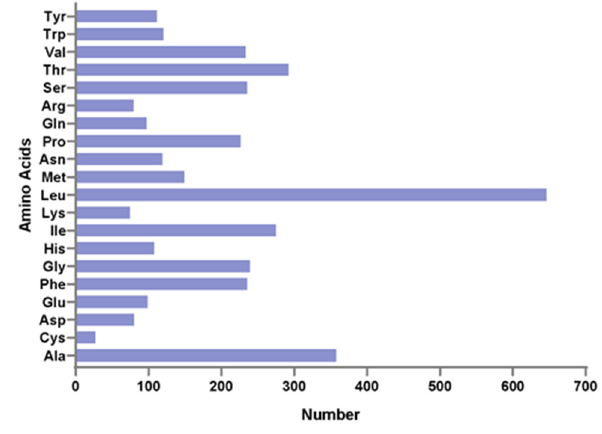
Figure 2. Amino acid distribution of the P. dentex mitochondrial genome. The horizontal axis and vertical axis are the number and types of amino acids, respectively.